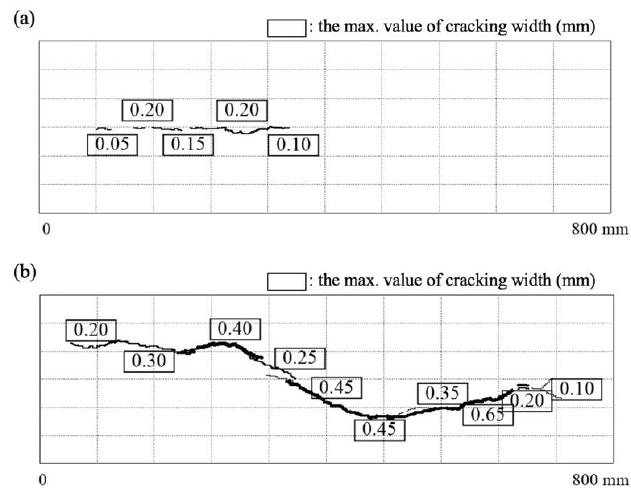
Figure 7. Cracking propagation due to corrosion expansion of steel bars: ( a ) specimen A with corroded steel ratio of 2.72%; ( b ) specimen B with corroded steel ratio of 3.95%.